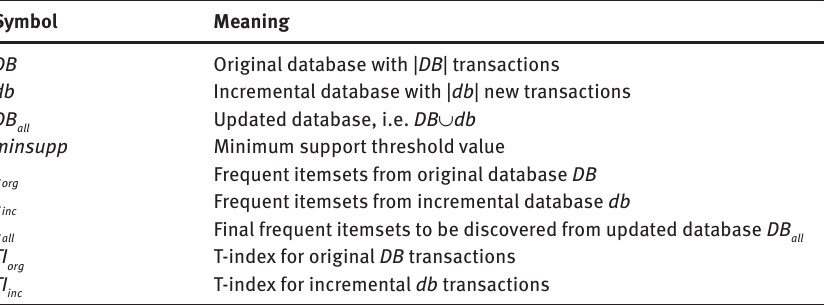
Table 2: The Symbols Used in the IMIDB Algorithm.